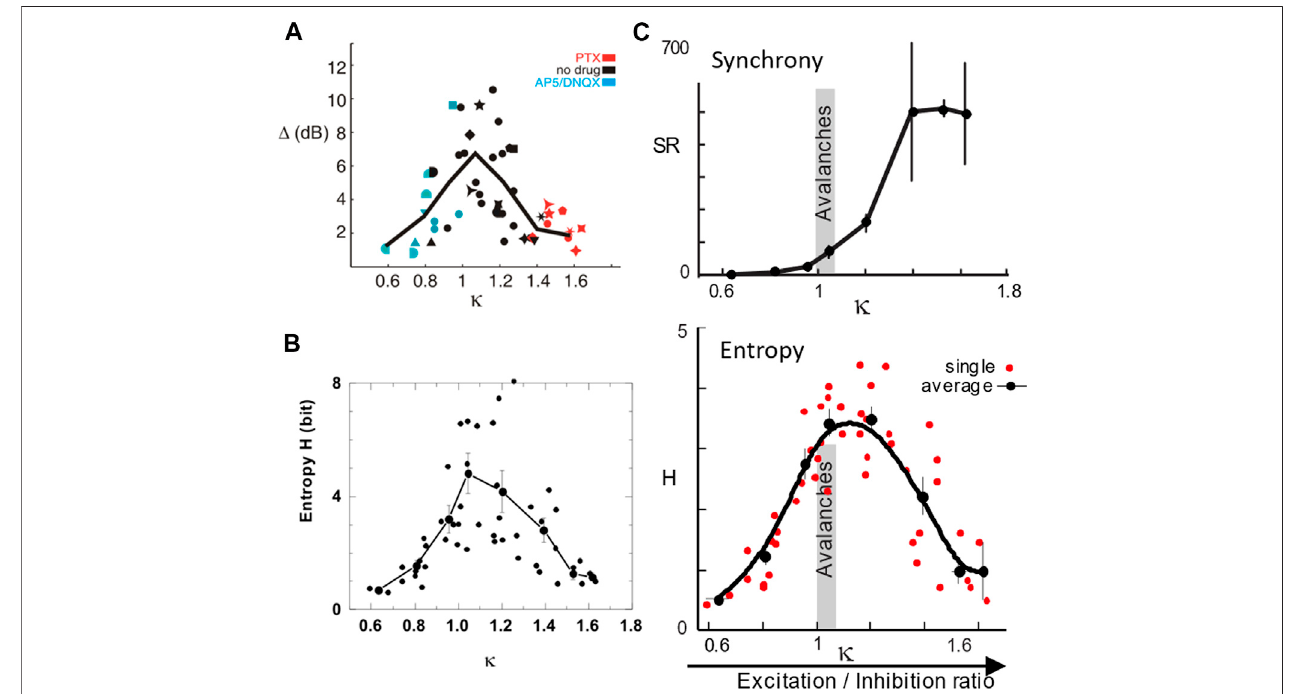
FIGURE11| TheE/I balance isacontrolparameterfortheemergenceofavalanches. (A) The dynamic range Δ ismaximizedwhen avalanche sizedistributions are closest to a power law. The parameter κ quanti fi es the Kolmogorov – Smirnov deviation at 10 equidistant steps of the actual cumulative size distribution from that of a power law[108,109].When κ (cid:2) 1,thedistributionisapowerlaw,whereas κ > 1forabimodaldistributionand κ < 1foranexponential distribution. (B) Informationcapacity is maximized close to κ (cid:2) 1. (C) Synchronization exhibits a phase transition at κ (cid:2) 1 ( top ) where the entropy of synchronization is maximal ( bottom ) and total synchronization is still orders of magnitude lower than that of the hyperexcitable regime for κ > 1. A – C are derived from LFP avalanches measured in organotypic cortex cultures with κ changed pharmacologically as indicated in A (reproduced from [108 – 110], respectively; Copyright 2009, 2011, 2012 Society for Neuroscience).